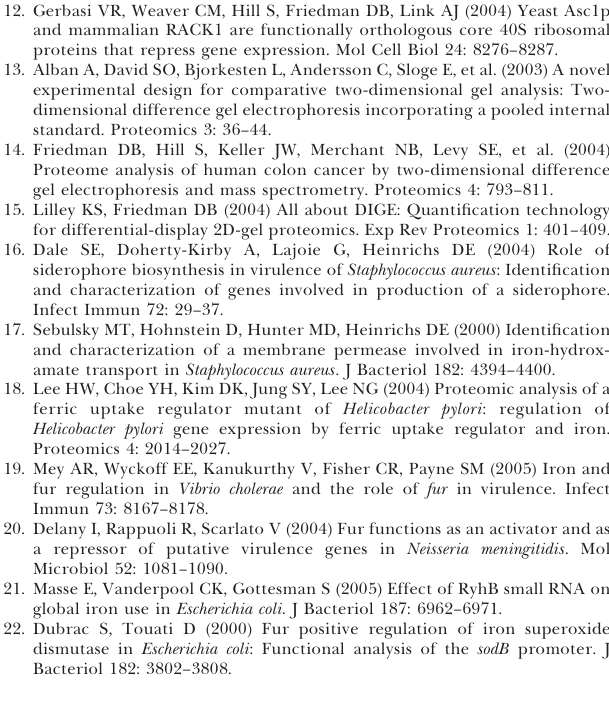
Table S1. Master Table of All DIGE Profiling and MS Database Search Results Found at DOI: 10.1371/journal.ppat.0020087.st001 (671 KB